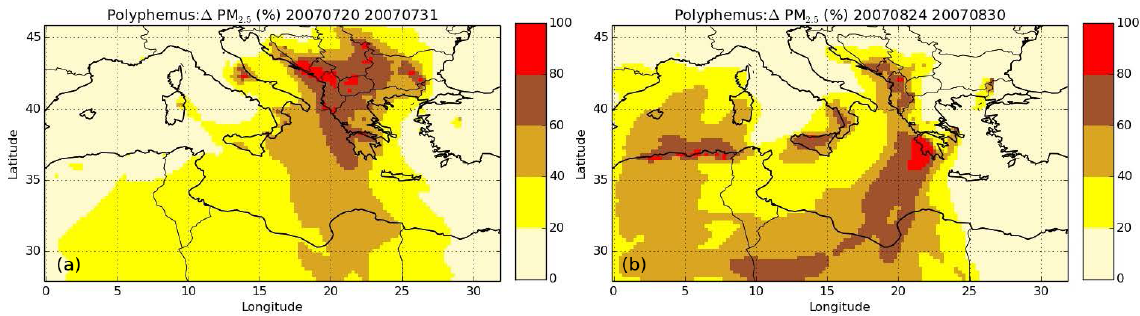
Figure 4. (a) Relative difference of surface PM 2 . 5 concentrations between simulations Poly-ref and Poly-Nofires during the first fire event. (b) Relative difference of surface PM 2 . 5 concentrations between simulations Poly-ref and Poly-Nofires during the second fire